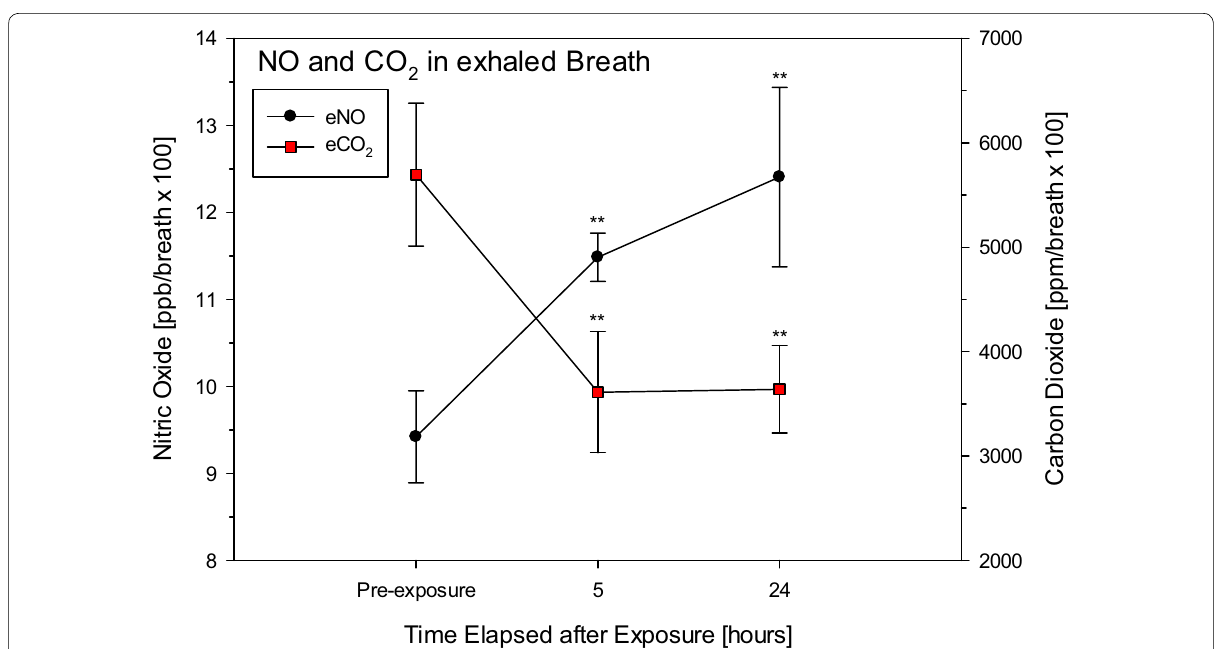
Fig. 6 Measurement of exhaled eNO and eCO 2 of rats 5 and 24 h post-phosgene exposure (for details see [43, 44, 46]). Sham control rats (denoted pre-exposure) served as concurrent control. Exhaled NO, CO 2 , and respiratory rate were digitally recorded every 10 s over a time period of 10 min. Data points represent means SD (n 3). Values were normalized to 100 breaths. Asterisks (*) denote significant differences to the air control ± = group (**P <